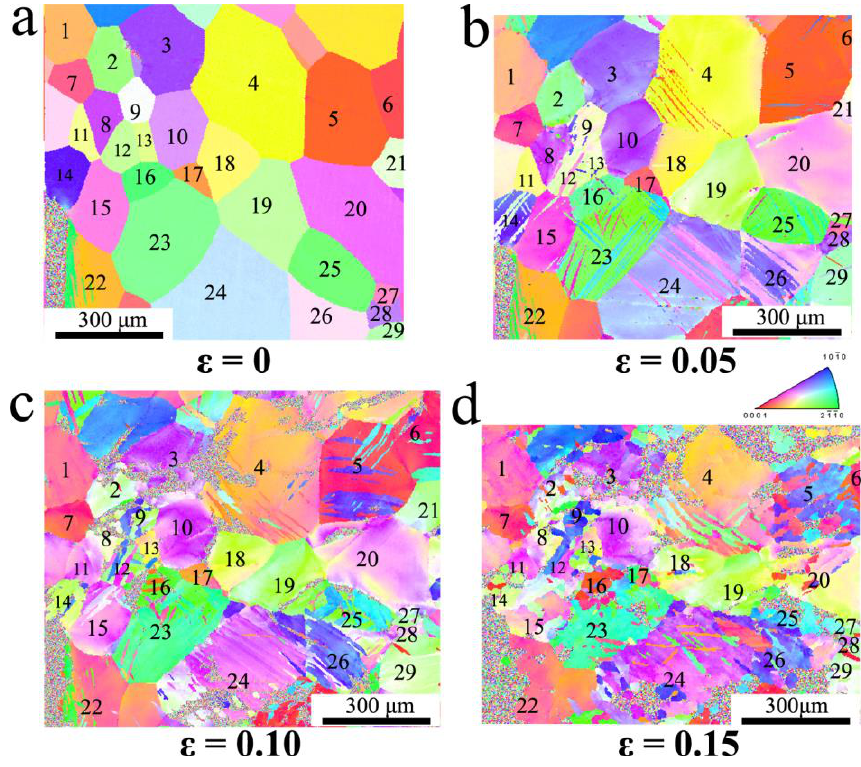
Figure 3. IPF maps of the observation area with strains of ( a ) 0; ( b ) 0.05; ( c ) 0.10; ( d ) 0.15.